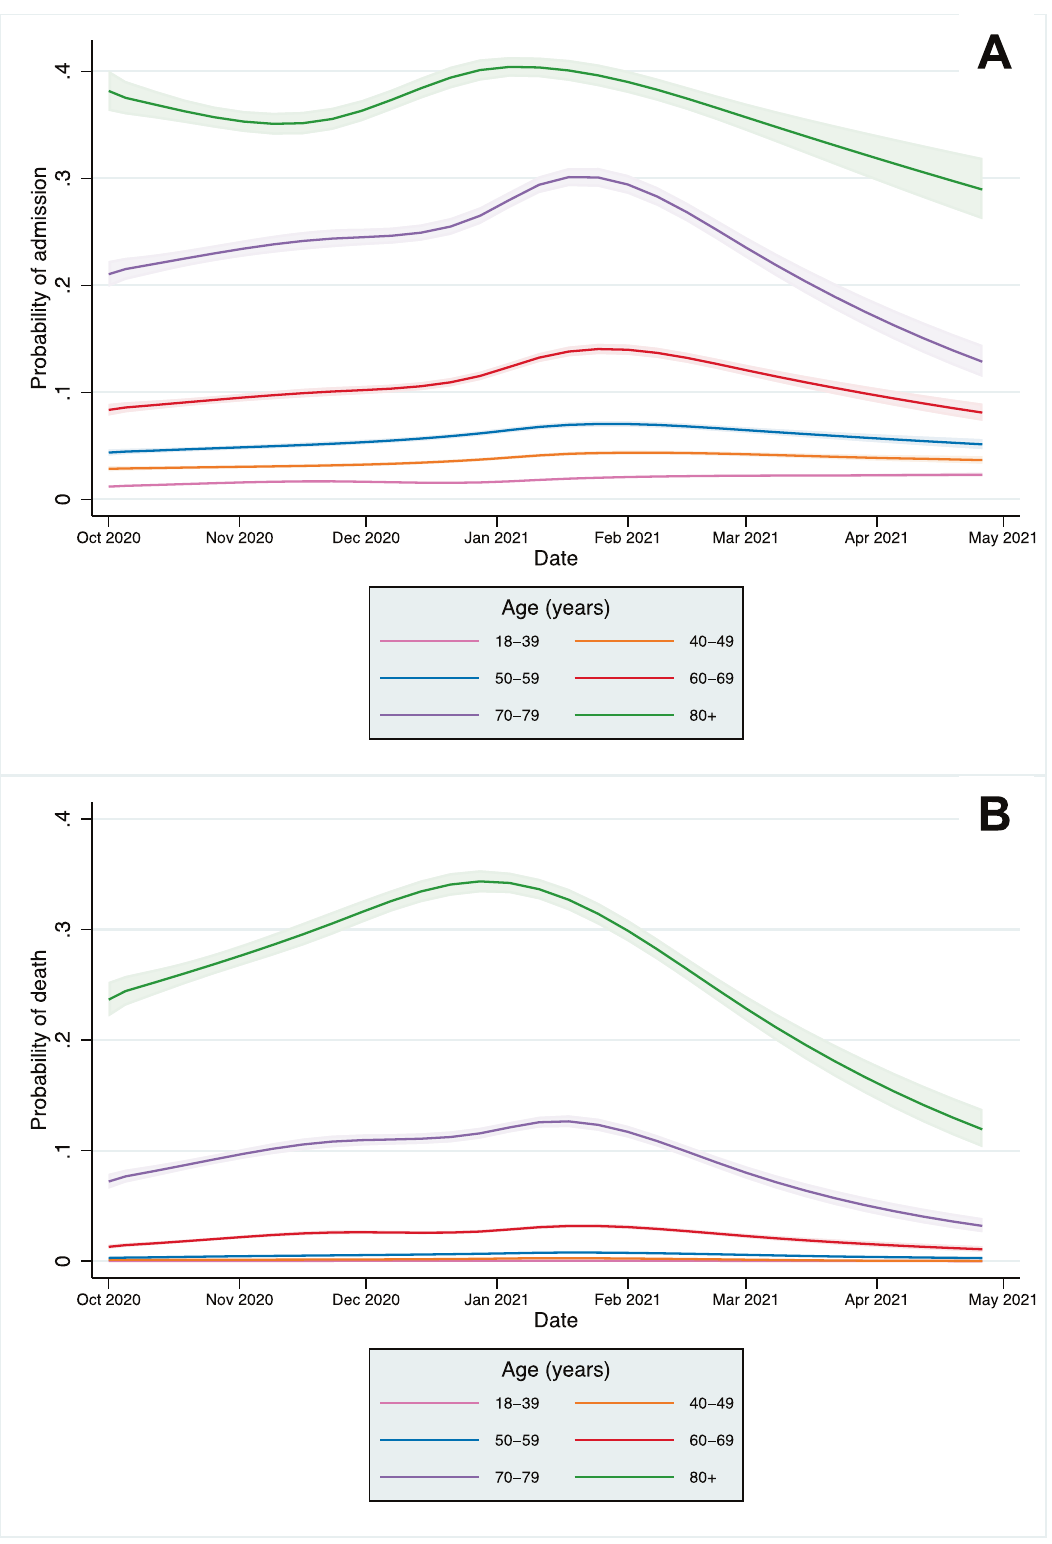
Fig. 3 28-day case hospitalisation risk and fatality risk over time in people with Covid-19. A 28-day case hospitalisation risk. B 28-day case fatality risk. Lines represent the probability estimate for each age group and shaded areas represent 95% con fi dence intervals from mixed effects logistic regression models, adjusted for patient-level covariates, at mean levels of each covariate ( N =